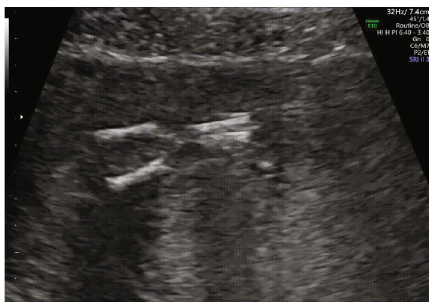
Figure 2: Gray-scale ultrasonography at the 14 weeks of gestation. Two femurs, two tibiae, and two fi bulae were visualized.